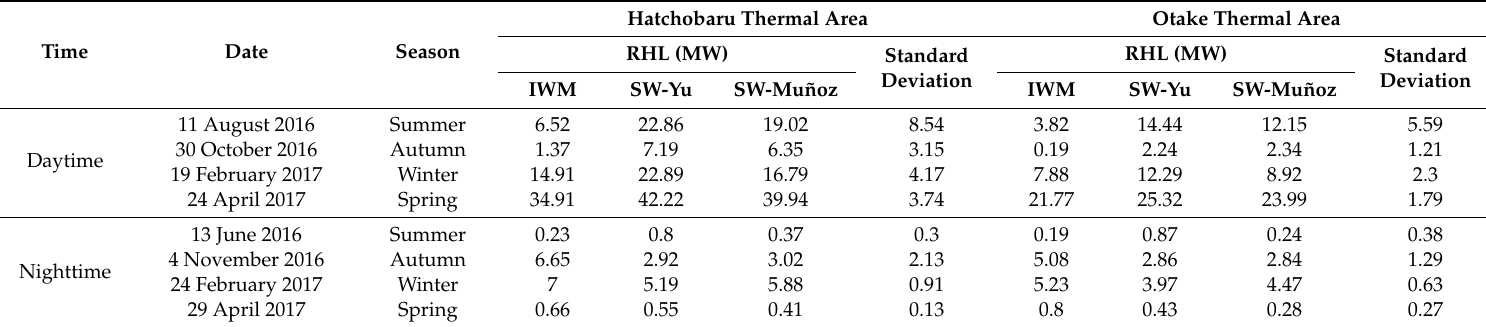
Table 7. Seasonal variation in both day and night estimates of heat loss within the Hatchobaru thermal area and Otake thermal area as shown circles in Figure 13 separately based on three different methods of land surface temperature estimation from Landsat 8 OLI/TIRS